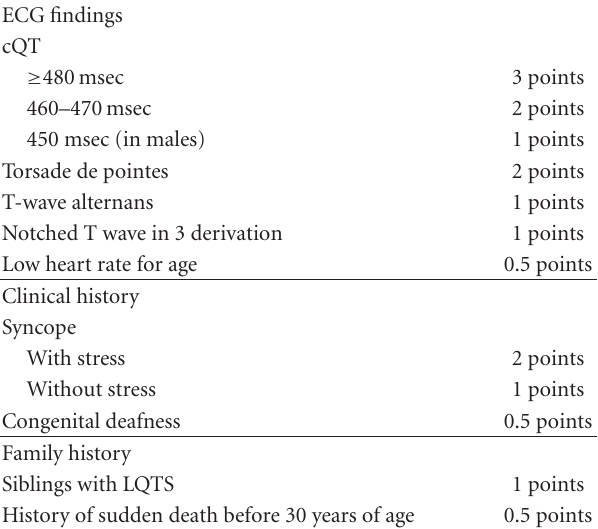
Table 1: Diagnostic criteria for